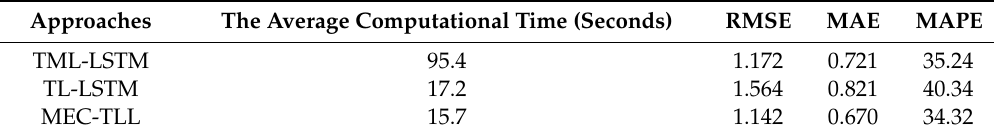
Table 2. Performance results of the experimental methods on the B2